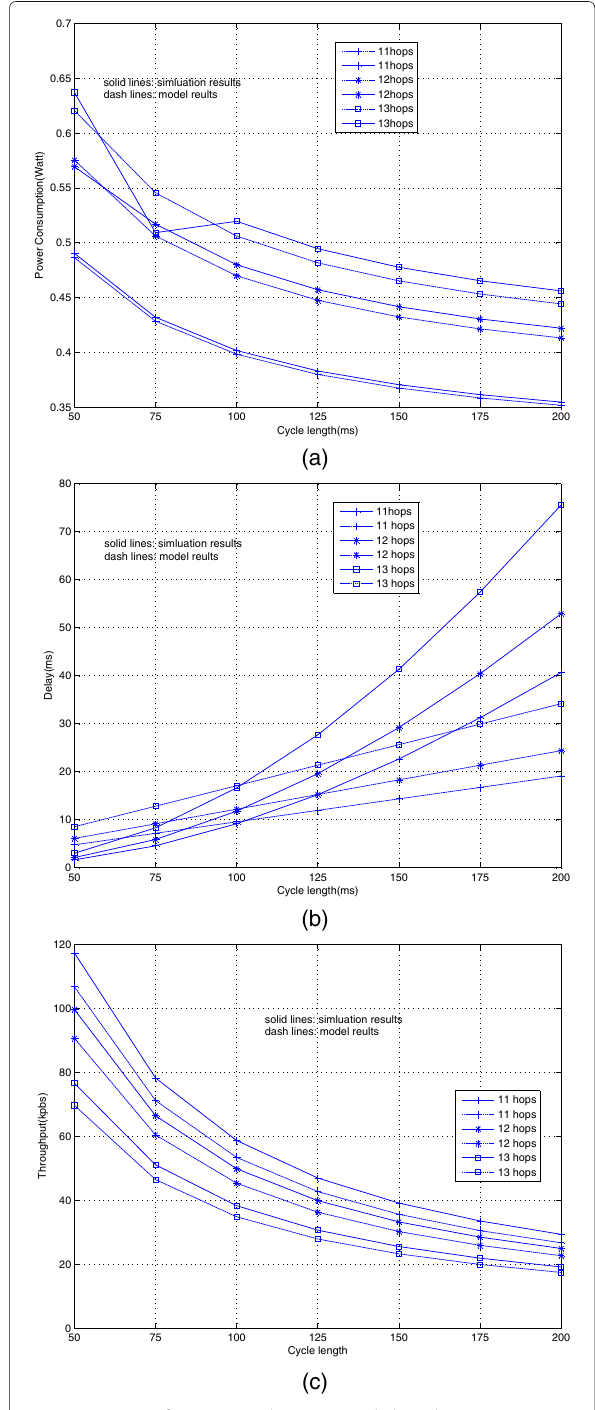
Fig. 7 X-MAC performance with varying cycle length. a Power consumption, ( b ) Delay, ( c ) Throughput